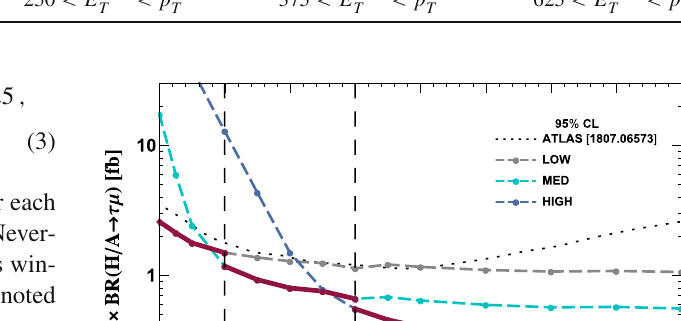
analysis, which is split in three different search strategies depending on the M H hypothesis. The cuts in each regime follow Eqs. (2) and (3)